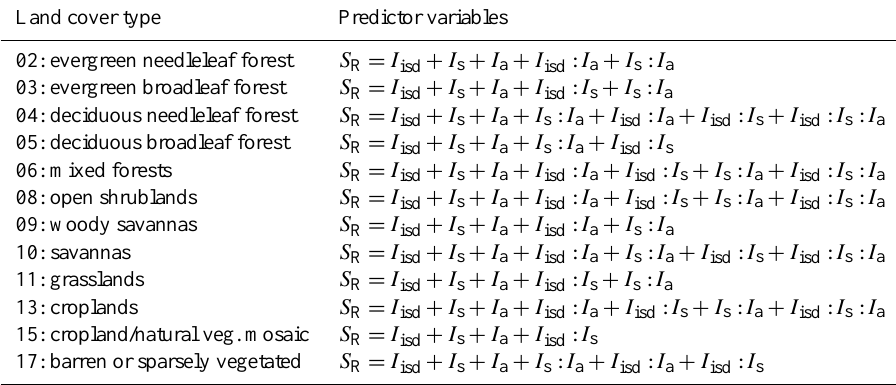
Table B1. Predictor variables selected by Akaike information criterion (AIC) for the different land cover types. The predictor variables are interstorm duration ( I isd ), precipitation seasonality ( I s ), and aridity index ( I a